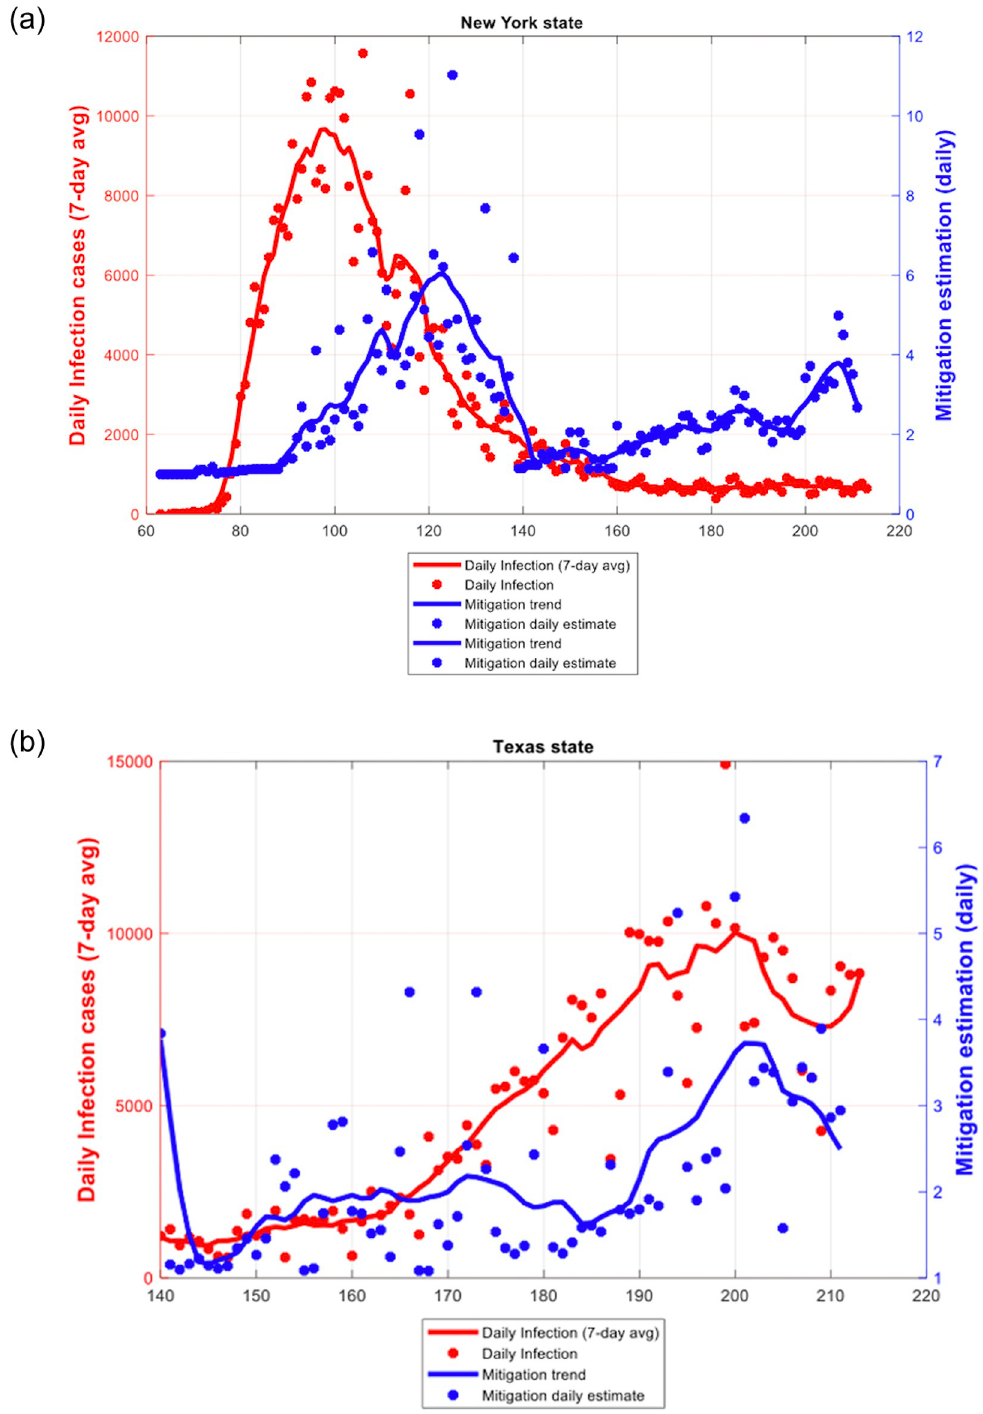
Fig 6. a. New York: Plots of mitigation function estimation (daily) vs daily infections (7-day average). Legend: This figure for New York shows the pattern of the relationship between the observed daily infection cases (red dots) with the mitigation function (blue dots). The red line is the 7-day average of confirmed daily infection cases. The blue line is the trend line of the mitigation function obtained by spline smoothing. b. Texas: Plots of mitigation function estimation (daily) vs daily infections (7-day average). Legend: This figure for Texas shows the pattern of the relationship between the observed daily infection cases (red dots) with the mitigation function (blue dots) as measured by the BSI. The red line is the 7-day average of confirmed daily infection cases. The blue line is the trend line of the mitigation function obtained by spline smoothing.